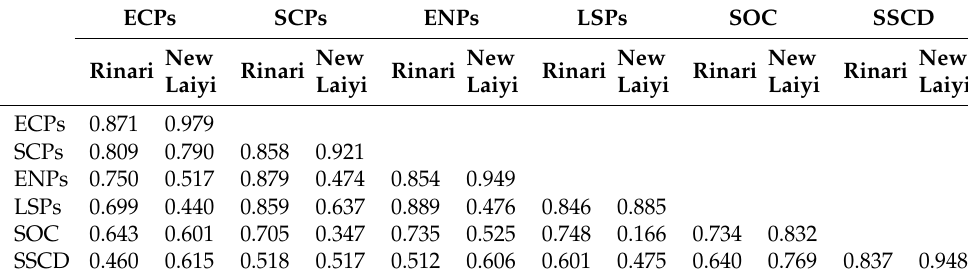
To test the discriminant validity of the measurement model, Table 4 lists the correla- tions between each latent variable and the square root of the AVE values. The correlation coefficients between the latent variables in New Laiyi are all below the square root of the AVE. However, some of the correlation coefficients between the latent variables in Rinari are greater than the square root of the AVE. Therefore, this study applied the confidence interval method to reconfirm the discriminant validity of the measurement model. As shown in Table 5, none of the indices in the 95% confidence interval of the correlation coefficient include 1.0, indicating that the measurement model has adequate discriminant validity without multicollinearity problems [78]. Table 4. Correlation coefficients and AVE matrix.